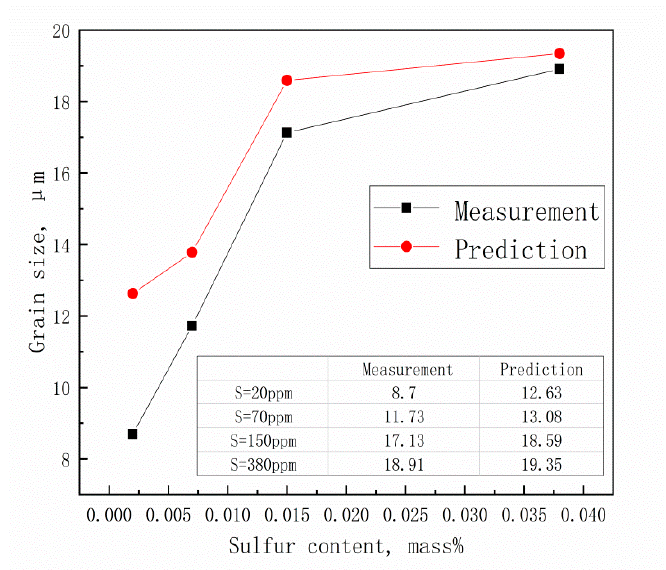
Figure 13. Measured and predicted values of F d after two-pass deformation.